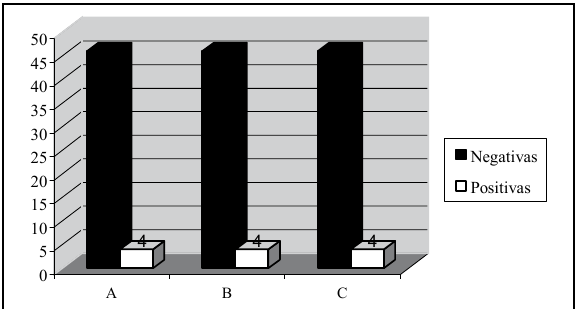
Figura 2 – Resultados obtidos com o teste do TTPAd da mistura de plasmas (PP + PN) realizada com A, B e